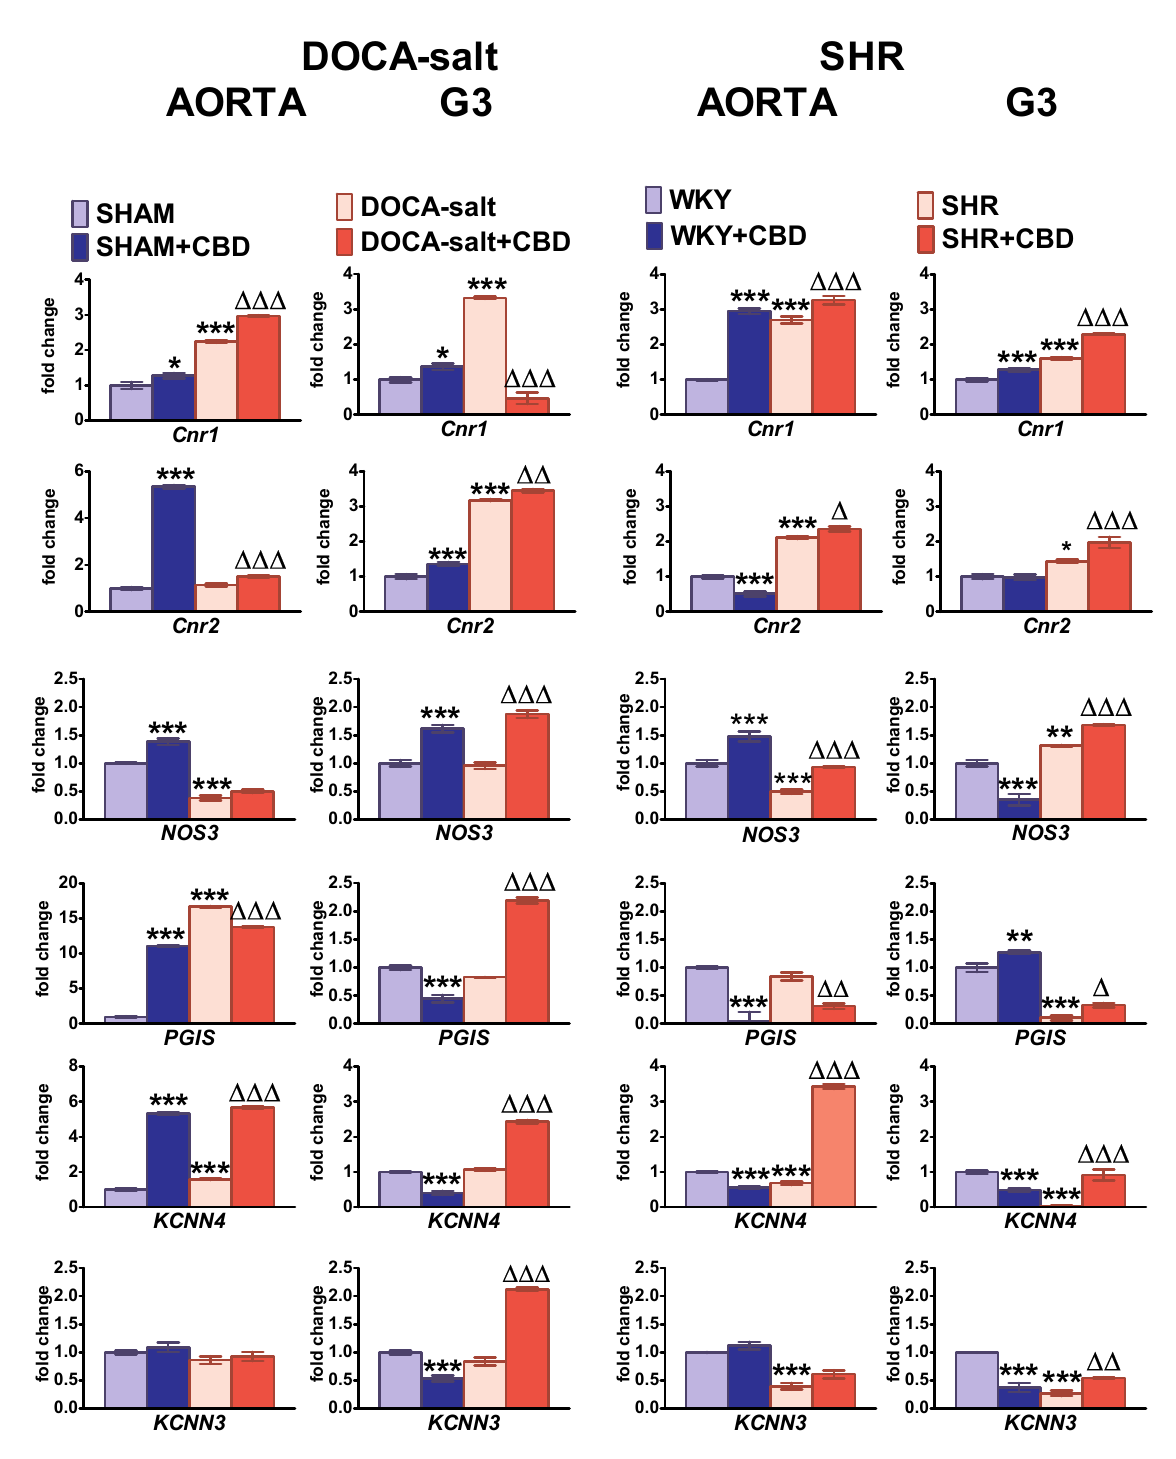
Figure 8. Influence of cannabidiol (CBD) and its vehicle on the relative expression of Cnr1, Cnr2, NOS3, PGIS, KCNN4 and KCNN3 as evaluated by real-time quantitative PCR in thoracic aorta and mesenteric G3 arteries isolated from deoxycorticosterone-induced (DOCA-salt) and spontaneously (SHR) hypertensive rats and their normotensive controls, sham-operated (SHAM) and Wistar–Kyoto (WKY) rats, respectively. CBD (10 mg/kg) or its vehicle was injected i.p. every 24 h for 14 days. Results are shown as mean ± SEM ( n = 6 per group), for the relative fold change in mRNA expression in comparison to the respective control, whose expression level was set to 1. * , ∆ p < 0.05, ** , ∆∆ p < 0.01 and *** , ∆∆∆ p < 0.001 compared to the respective control groups (* SHAM/WKY or ∆ DOCA-salt/SHR), as determined by one-way ANOVA followed by Bonferroni’s multiple-comparison